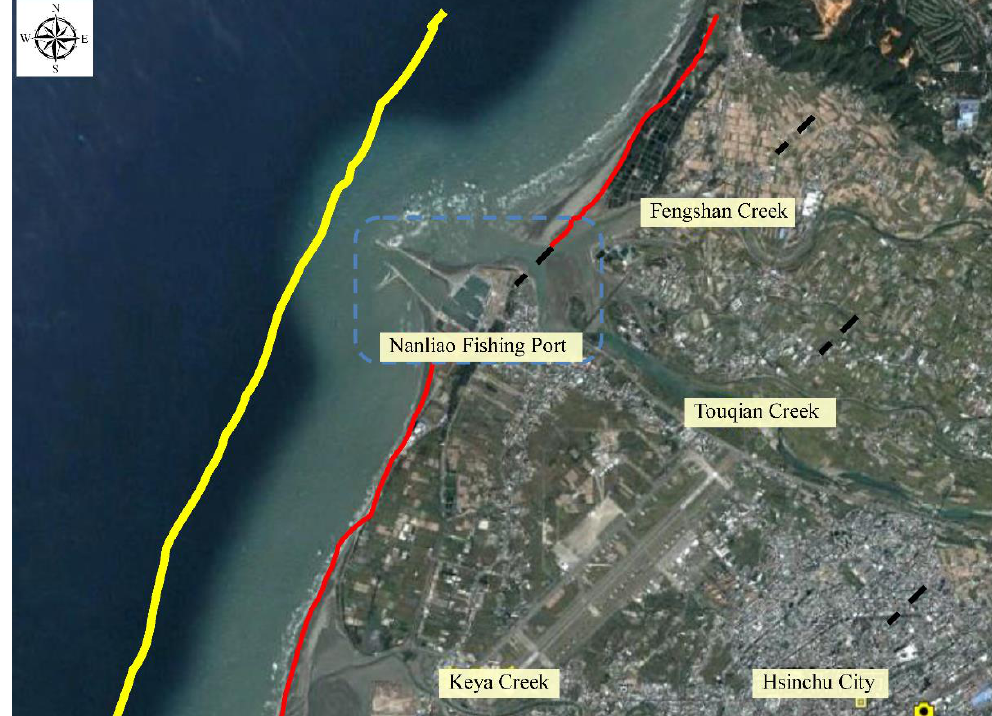
Figure 9. Preliminary planning results of coastal buffer zone using the SBEACH and wave run-up models (Nanliao Fishing Port, Hsinchu, Taiwan) [56]. (Red line: the onshore boundary of the coastal buffer zone; yellow line: the offshore boundary of the coastal buffer zone.).